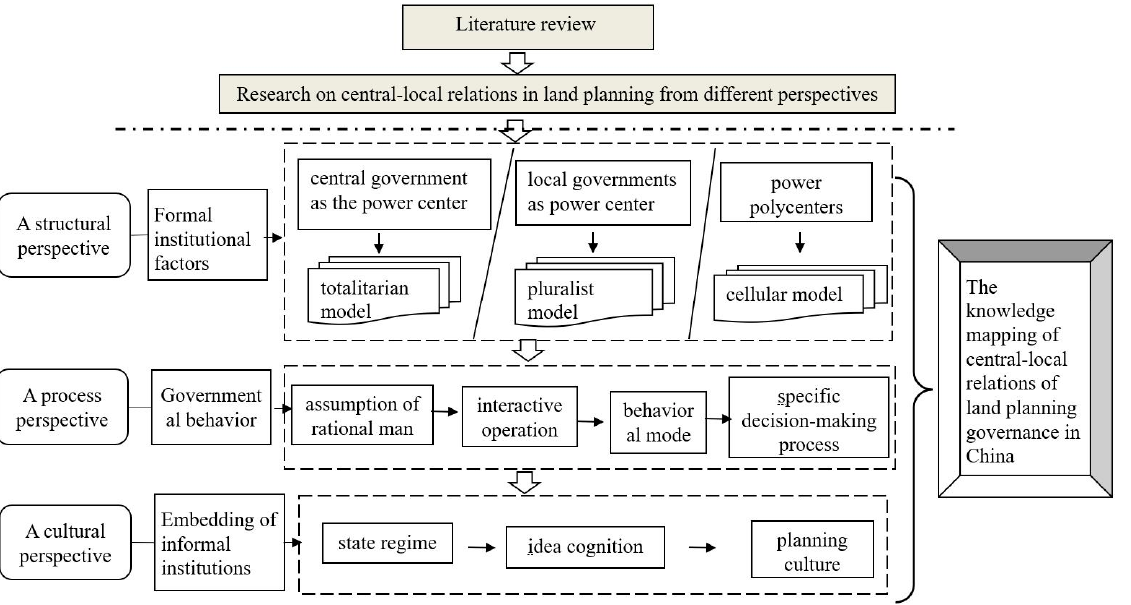
Figure 1. Analysis framework for the literature review.